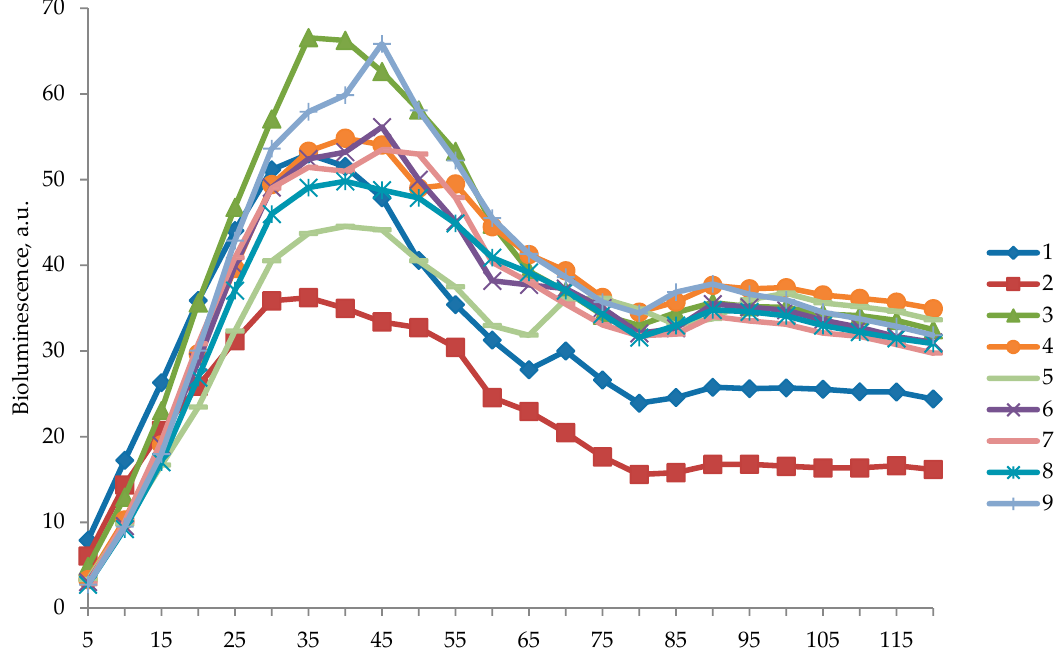
Figure 2. Bioluminescence induction factor of Escherichia coli strain MG1655 (pKatG) in the presence of hydrogen peroxide (H 2 O 2 ) in the concentration of 10 − 3 mol / L, with an addition (within 30 min) of C 60 suspensions in 2% aqueous solution of TWEEN 80 in di ff erent concentrations, varying from 10 − 15 g / L to 10 − 3 g / L. 1: TWEEN 80 with hydrogen peroxide (H 2 O 2 ); 2: H 2 O 2 ; 3: Fullerene C 60 in a concentration of 10 − 15 g / L with H 2 O 2 ; 4: C 60 10 − 12 g / L with H 2 O 2 ; 5: C 60 10 − 9 g / L with H 2 O 2 ; 6: C 60 10 − 6 g / L with H 2 O 2 ; 7: C 60 10 − 5 g / L with H 2 O 2 ; 8: C 60 10 − 4 g / L with H 2 O 2 ; 9: C 60 10 − 3 g / L with H 2 O 2 .